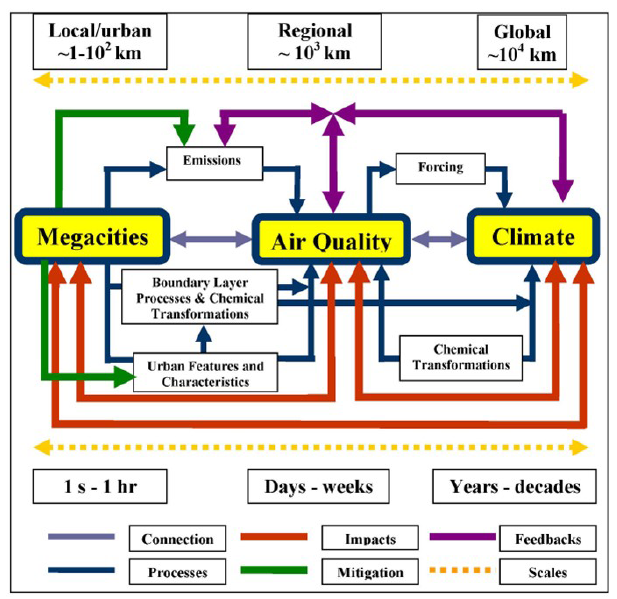
Figure 12. The main linkages between urban emissions, air quality, and climate. (Baklanov et al.,